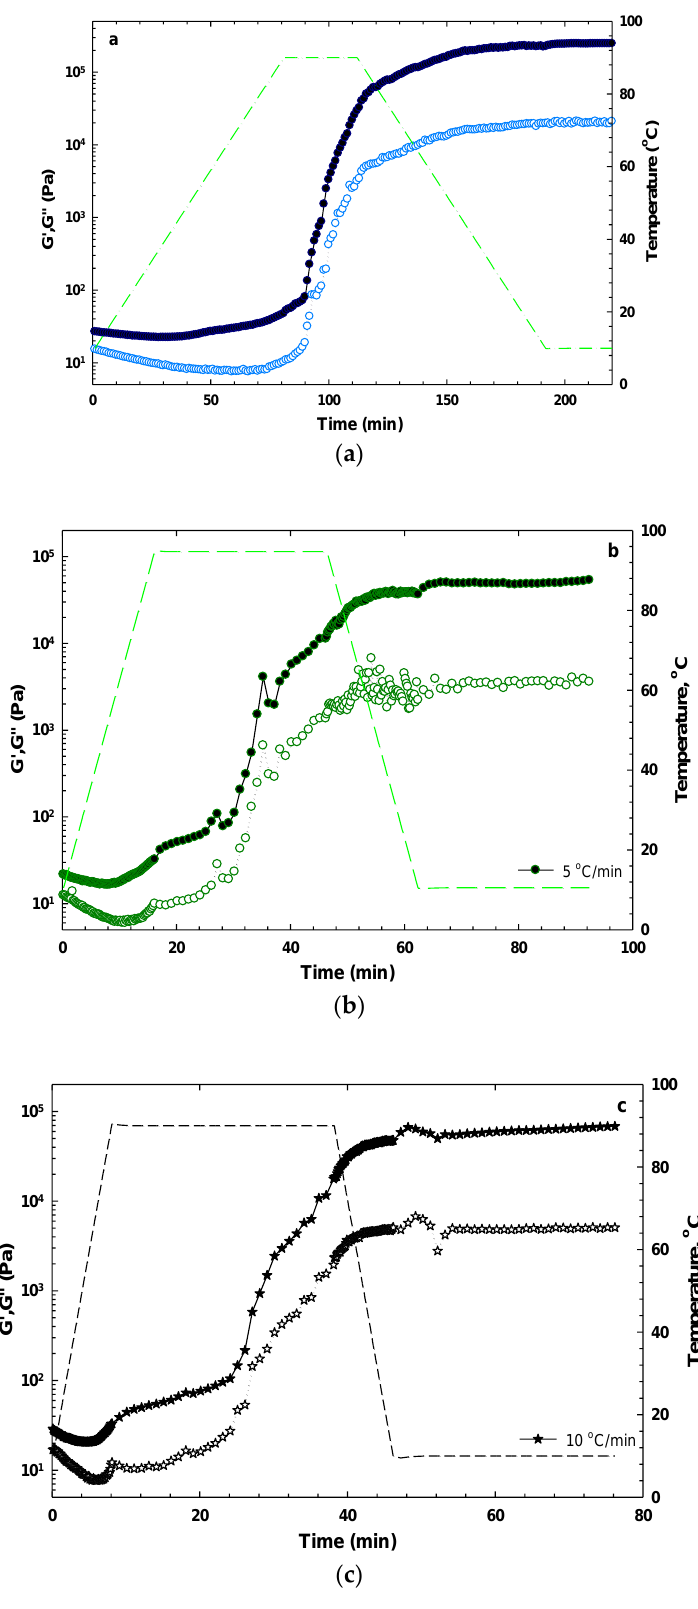
Figure 4. Effect of heating/ cooling rate on the G′ (filled symbols) and G′′ (blank symbols) of SISH dispersions at 1% concentration: ( a ) 1 °C/min, ( b ) 5 °C/min, and ( c ) 10 °C/min. All measures were conducted at the frequency of 1 Hz with the strain amplitude of 0.5%.